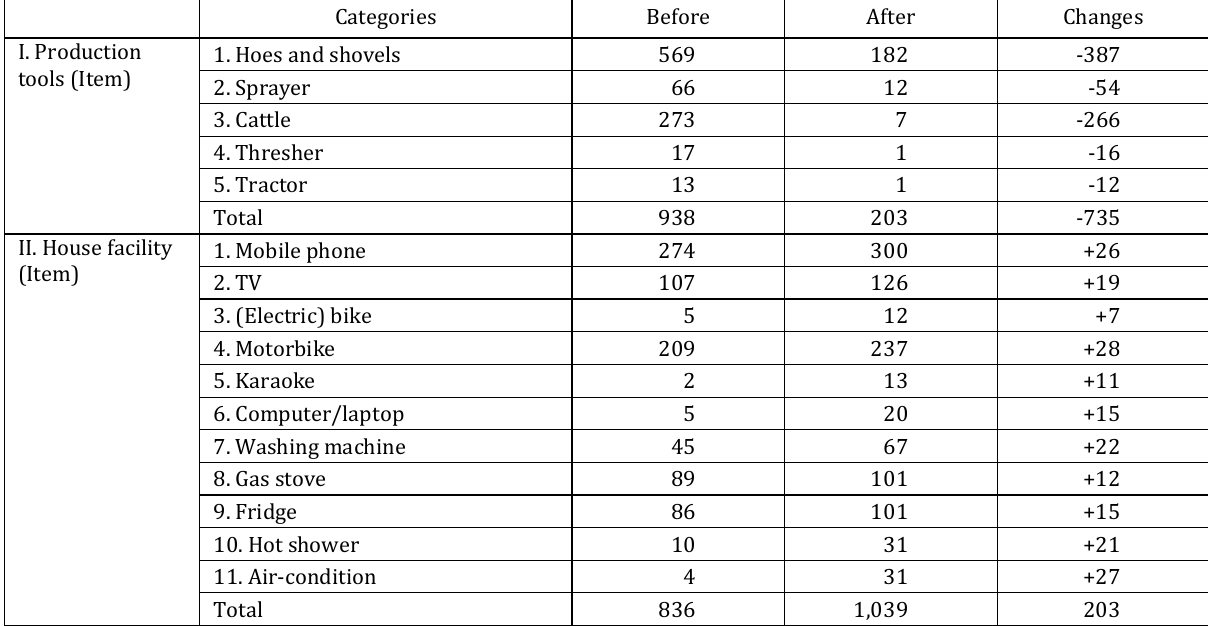
Table 5. Changes in equipment before and after land acquisition (Source: Households' survey, 2020)